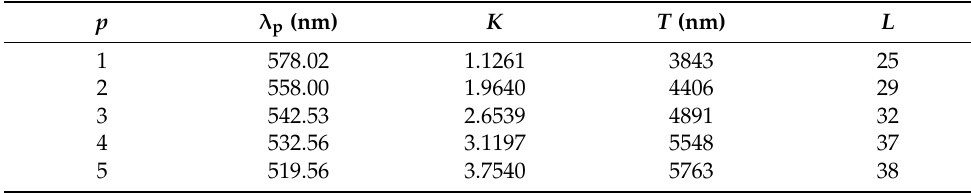
Table 2. Calculated CPC parameters according to Fabry–P é rot